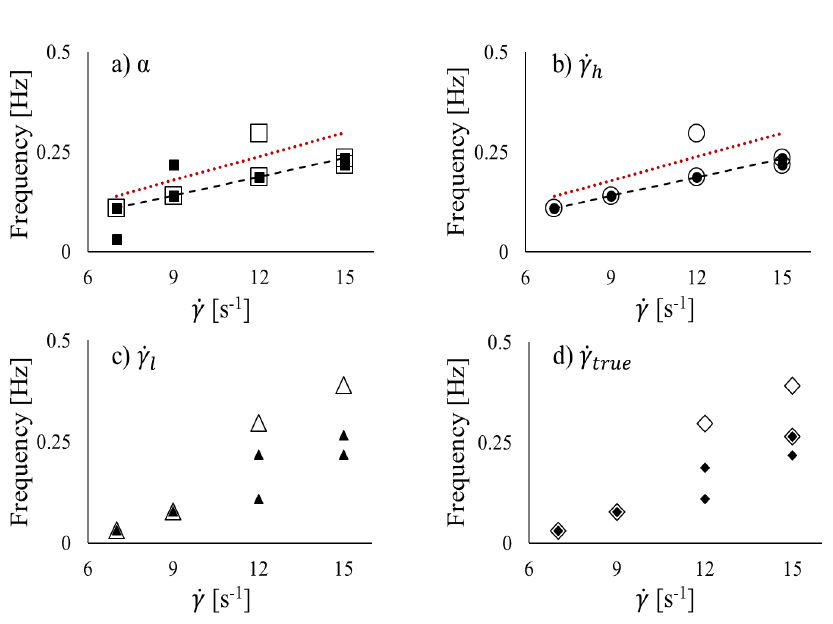
Figure 10: The dominant frequencies in the spectra for protocol 1 (filled symbols) and protocol 2 (open symbols) plotted as a function of applied shear rate for (a) the interface position α (b) the shear rate in the high shear band ˙ 𝛾 and (d) the true shear rate ˙ 𝛾 . Red dashed lines show rotation frequencies corresponding to the applied shear rates, while black dashed true lines correspond to the linearly varying rotationally correlated observed